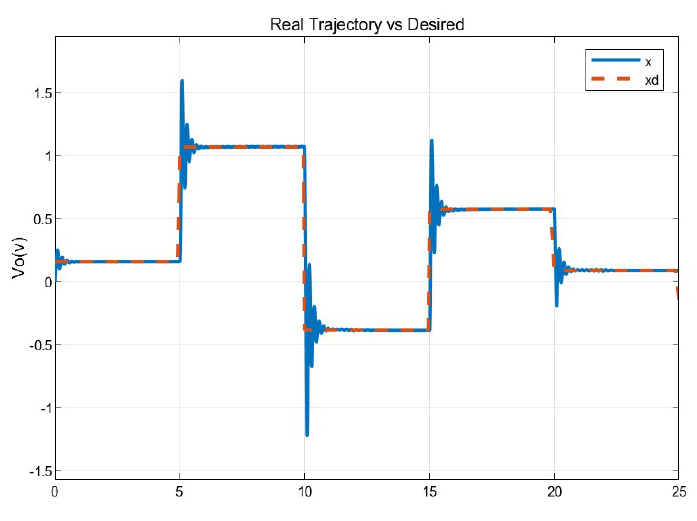
Figure 10. Auto tuning PID gain simulation and implemented in conventional PID control.